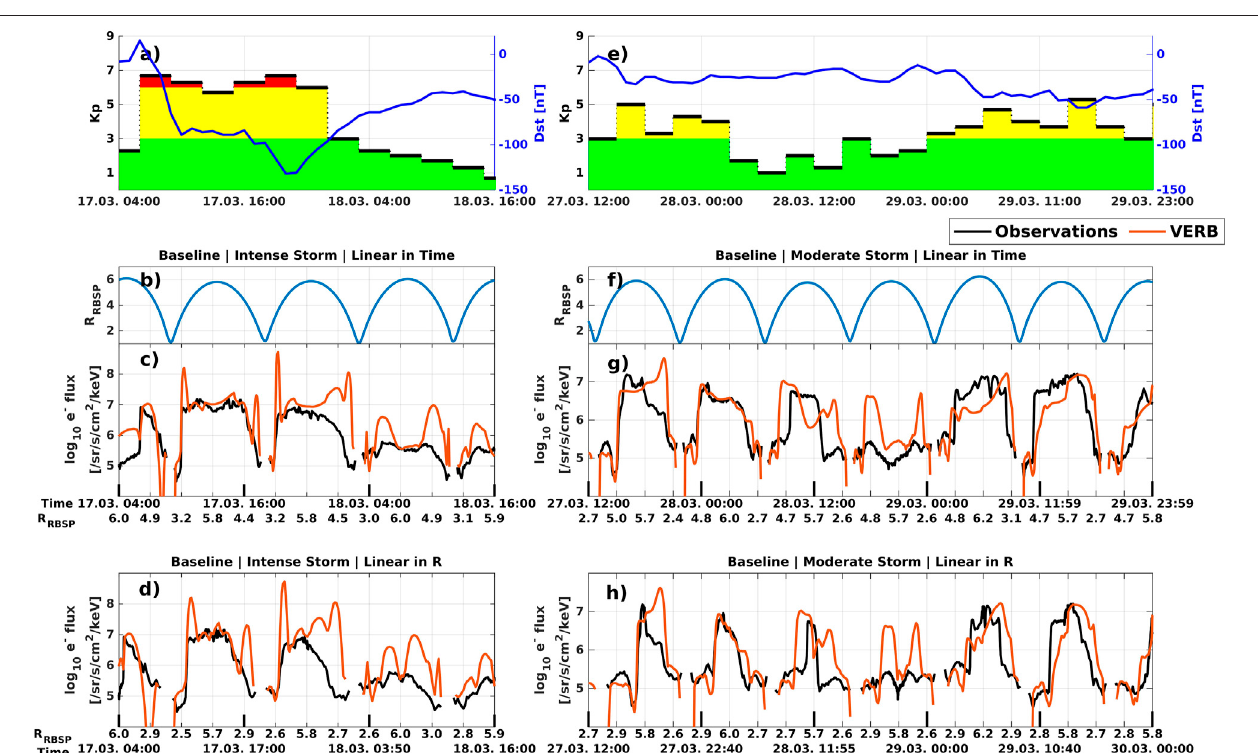
FIGURE1| KpandDsttimeseriesandresultsofthesimulationsinMarch2013. (A) Kp(bars)andDst(blueline)timeseriesoftheintensestorm. (B) Radialdistance ofRBSP-Borbit mapped totheequatorialplane during theintensestorm. (C) Comparison ofRBSP-B(black) and baseline VERB-CS result (red) for 10 keVelectron fl ux at 54 ° local pitch-angle at the spacecraft ’ s location. (D) Same data as in (C) but linearized in radial distance. Panels (E – H) have the same format as (A – D) but for the moderate storm.